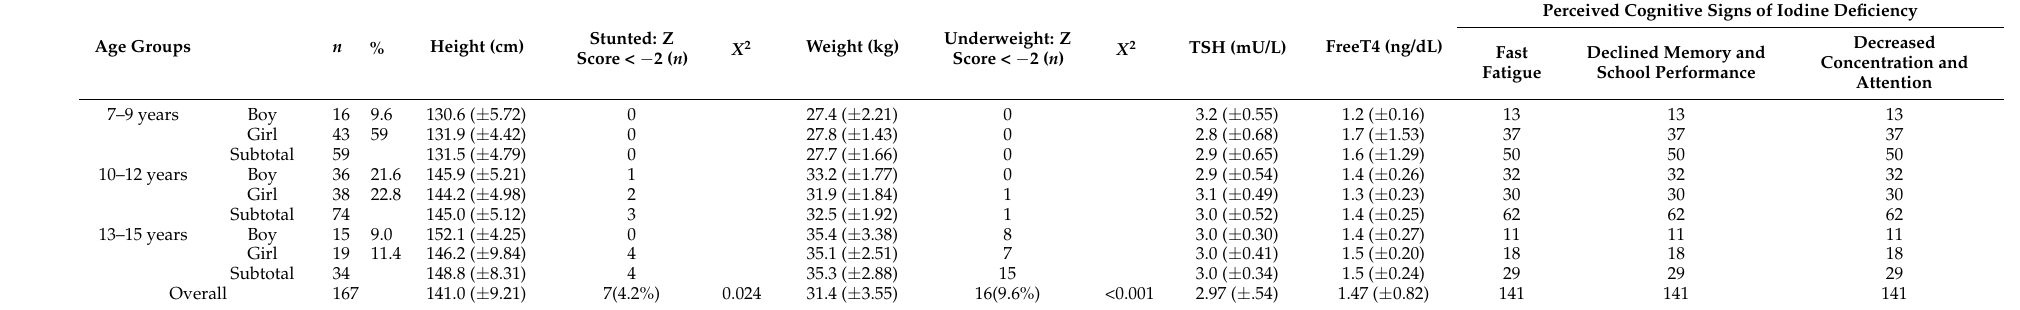
Table 3. Clinical characteristics of school children with enlarged thyroids ( n =